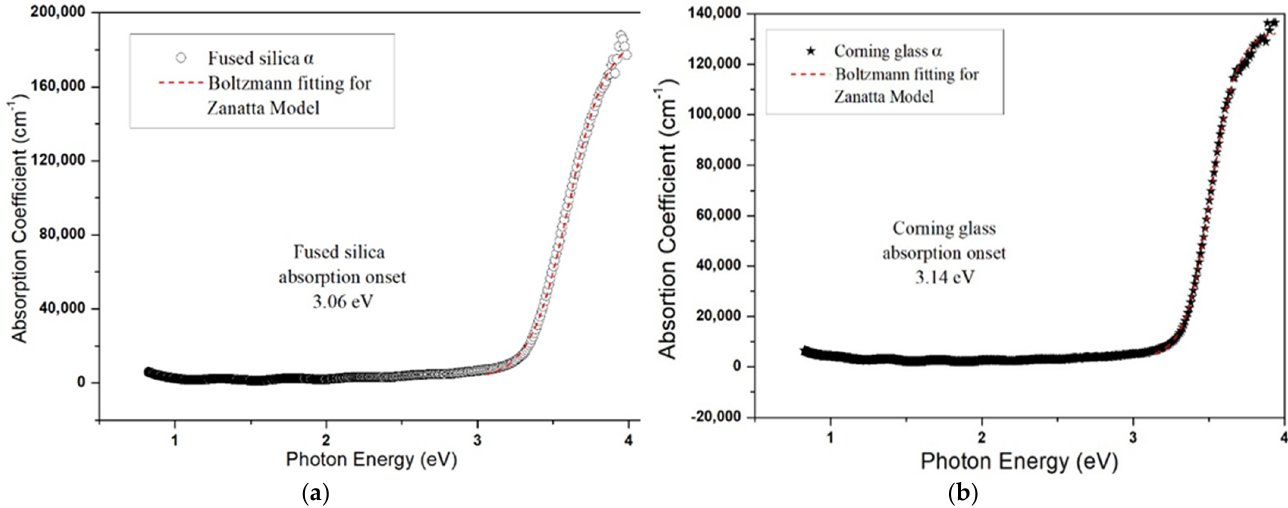
Figure 5. Scatter plot of absorption coefficient against photon energy for ZnO:Al films deposited on ( a ) fused silica substrate and ( b ) glass substrate. A Sigmoid-Boltzmann fit for the absorption coefficient for each film is presented using a red line. The absorption onsets were determined to be 3.06 and 3.14 eV, respectively.